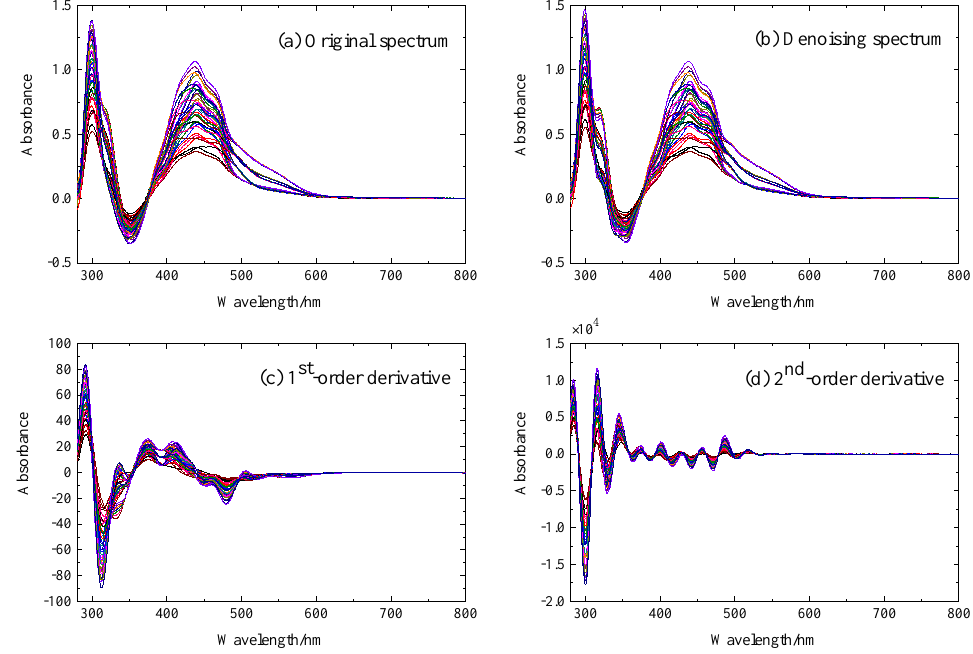
Figure 5. The original, denoising, first-order, and second-order derivative spectra of the training set. Table 2. Error evaluations of full-spectrum among different preprocessing methods for metal ions concentration